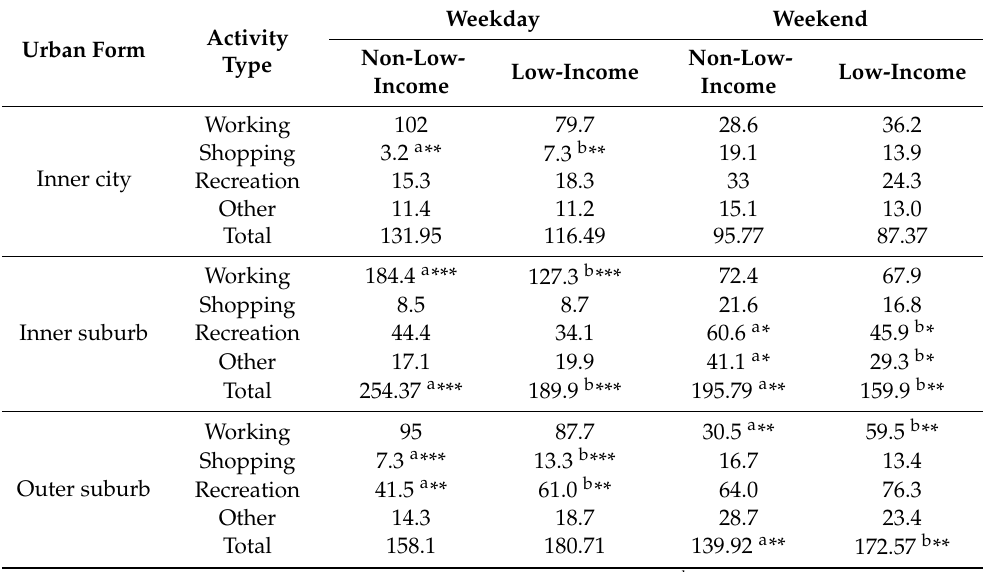
Table 3. Differences in the time distribution of the out-of-home activities among different income groups by urban space (mean value,